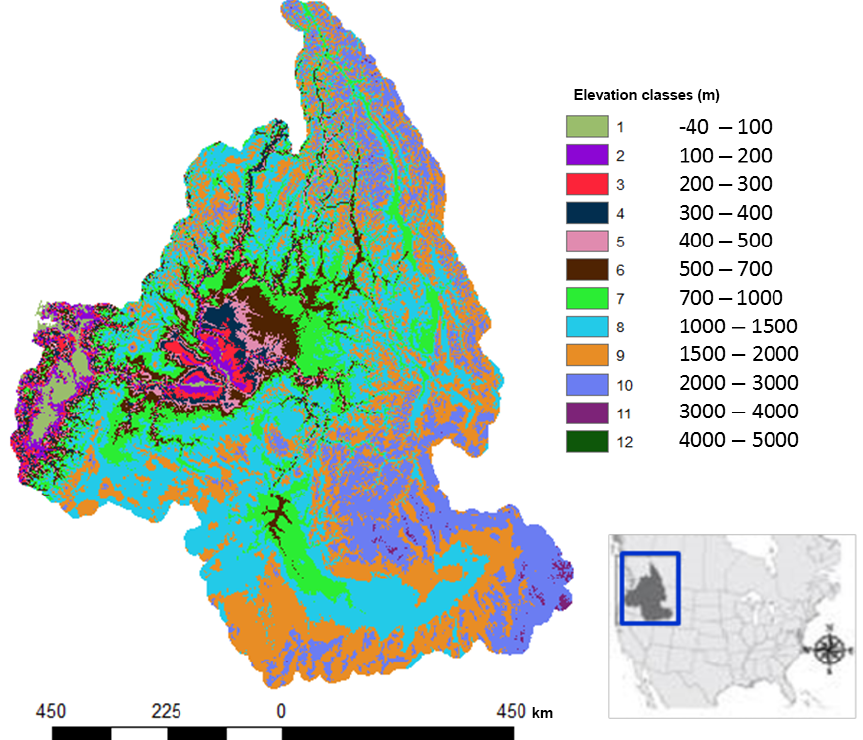
Figure 2. The study area classified into elevation bands used in the global method, following the approach described in Leung and Ghan (1995,